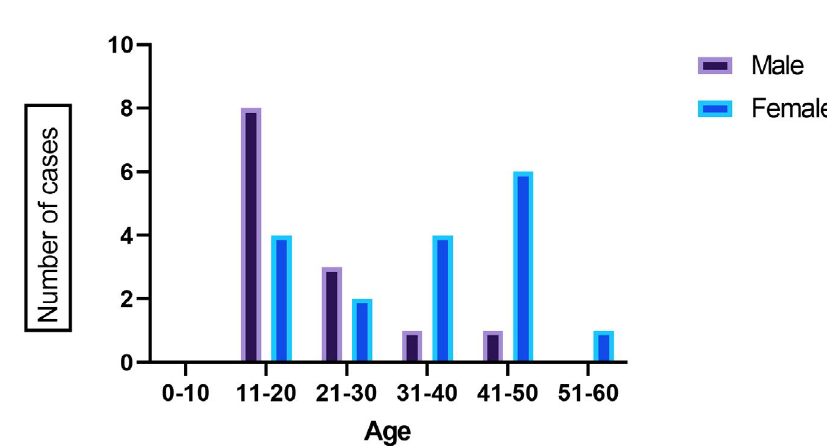
Fig. 1. Distribution of patients according to sex